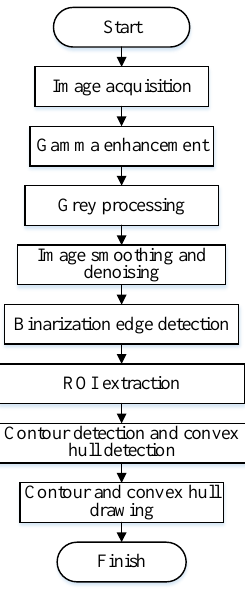
Figure 3. Algorithm flow.